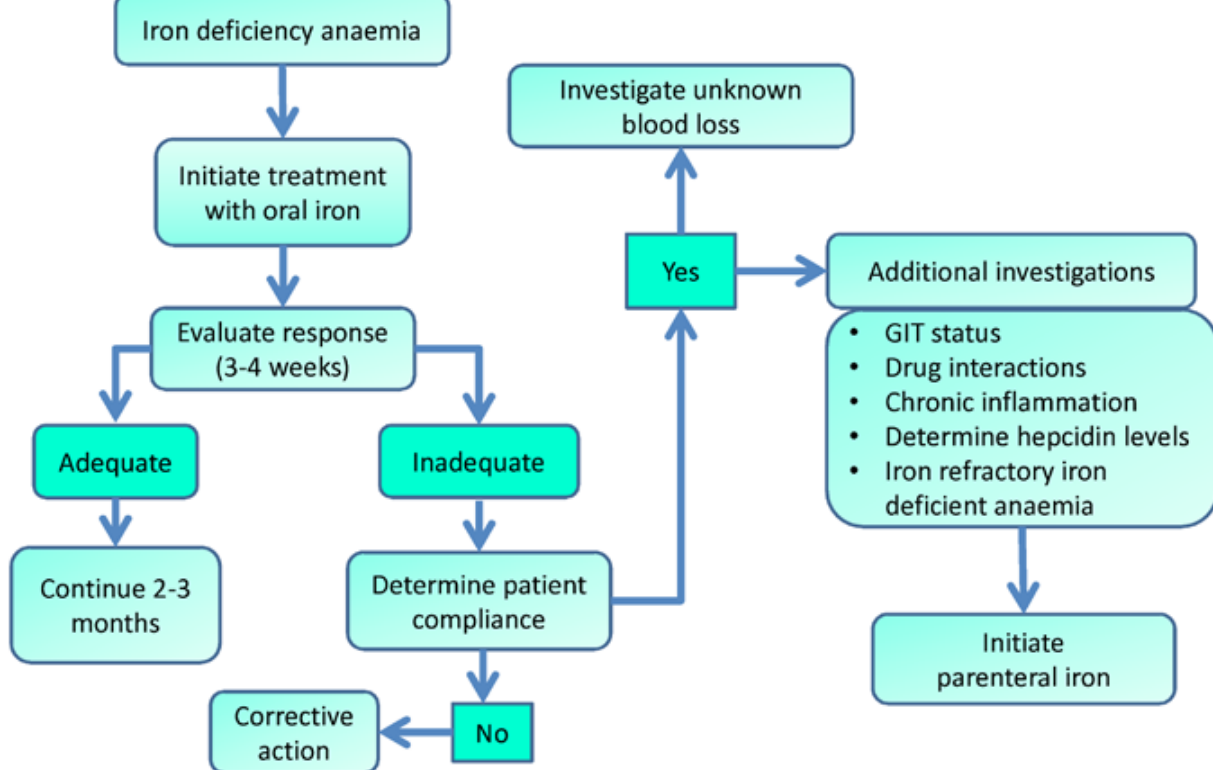
Figure 2: Flow-diagram outlining the management of the iron deficient anaemic